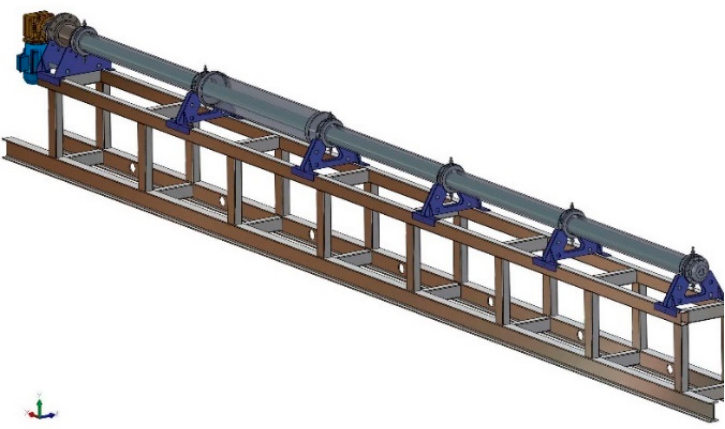
Figure 1. Test section with inlet to the right and outlet to the left. A torque motor for the rotating inner pipe is mounted at the outlet.